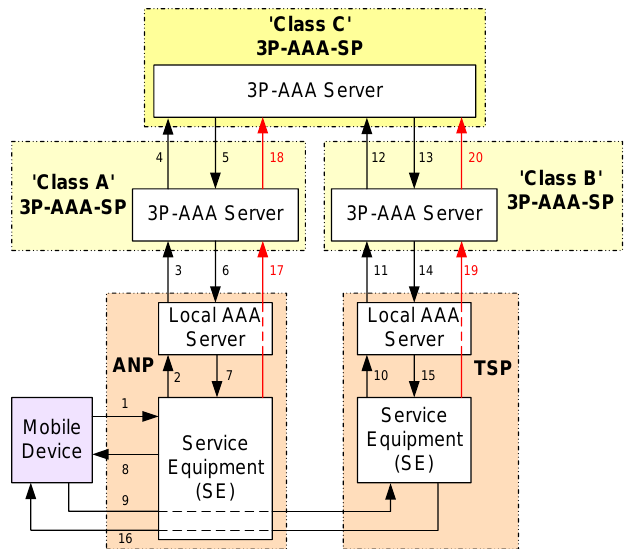
Figure 4. An example illustrating the signaling and message exchange sequence across relevant inter-domain interfaces for the pull authorization model, which includes a combination of an ANP and a TSP for service provision (without any HAC